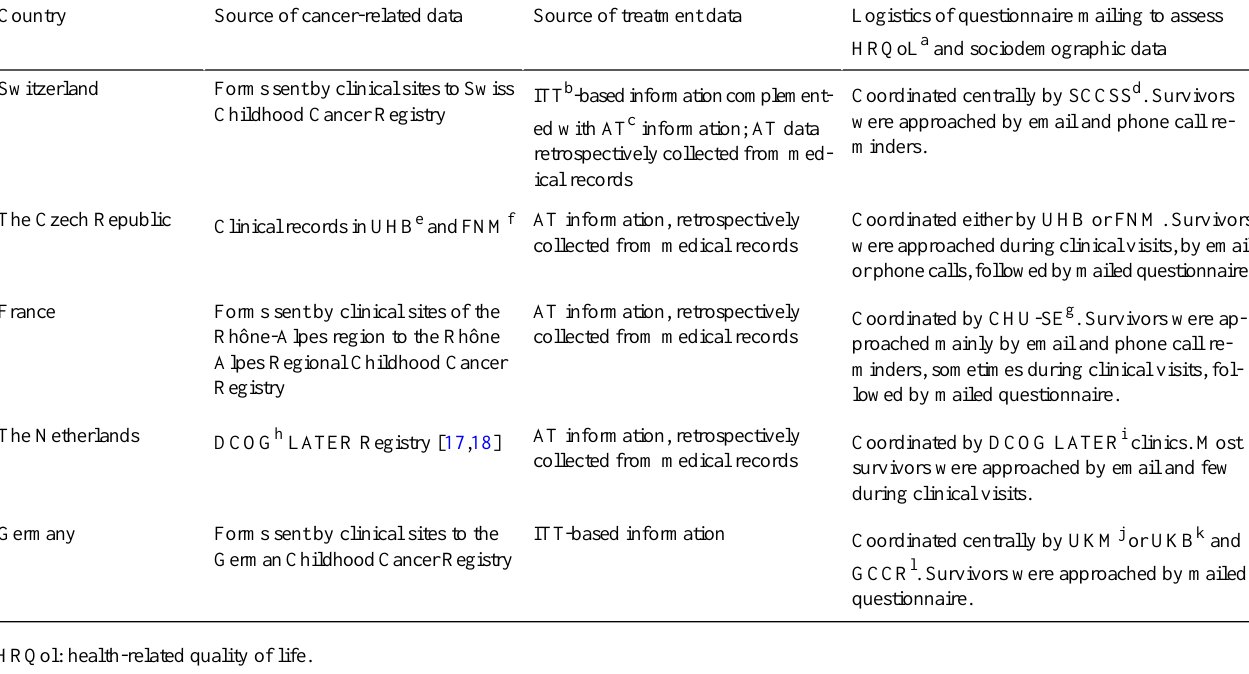
Table 4. Sources of cancer-related and treatment data and logistics of paper-pencil questionnaire assessment of health-related quality of life, by